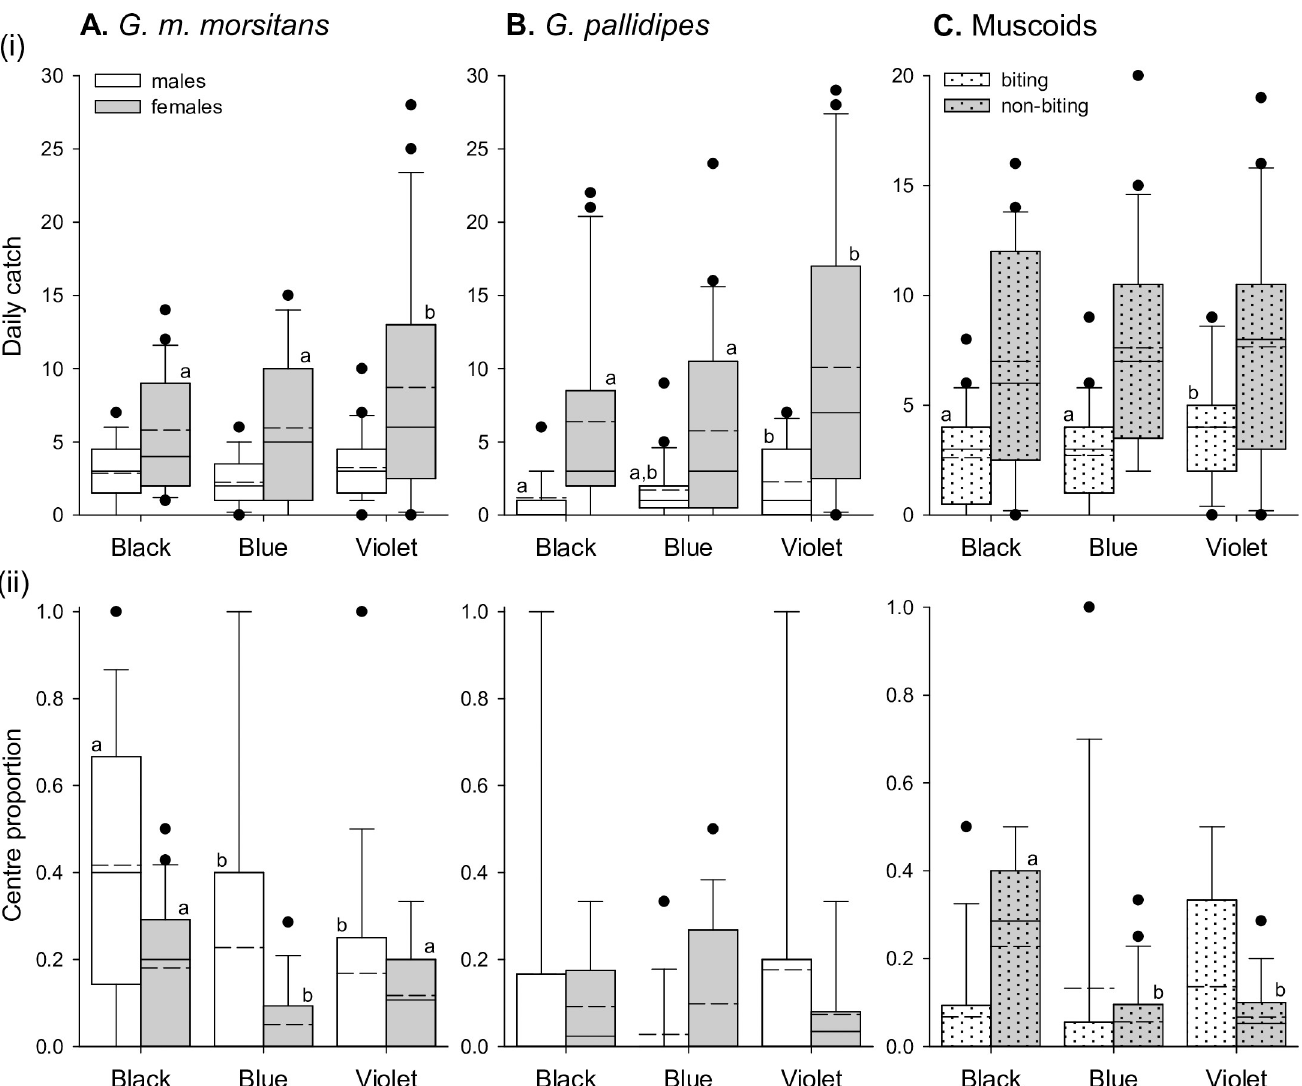
Fig 5. Catches of biting flies at new polyester and traditional cotton targets without odour lures. Data are plotted for male and female G . m . morsitans (A), and G . pallidipes (B), and for biting and non-biting muscoid species (C). (i) Upper panels show daily catches recorded on each sampling day. (ii) Lower panels show the proportion of the catch that was intercepted at the centre panel on each sampling day. Target designs are described in Table 1, and data are from a total of 7 Latin squares encompassing 21 sampling days. Figure conventions are as described for Fig